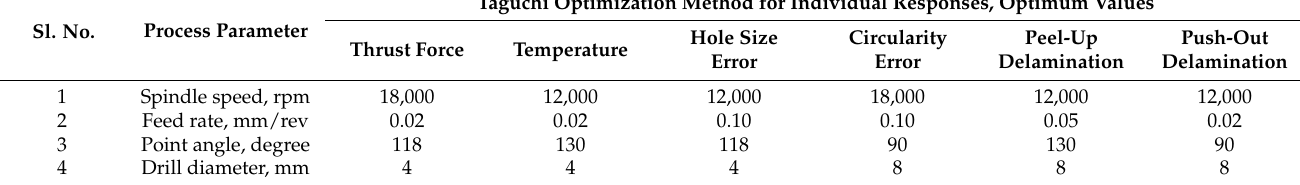
Table 4. Optimum machining conditions for individual